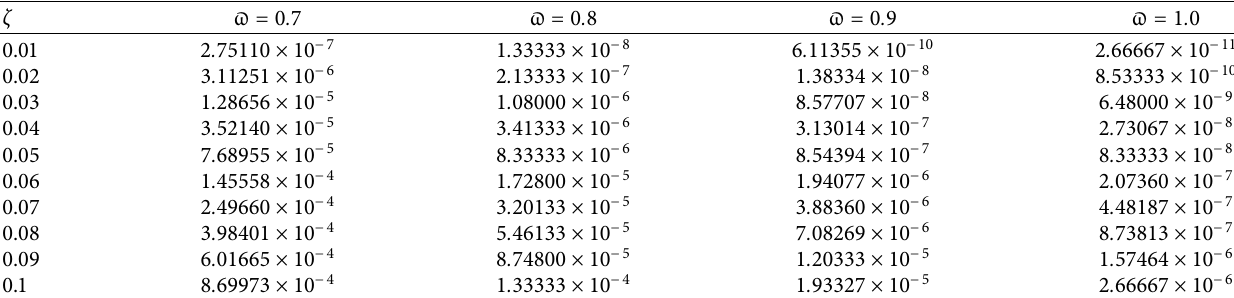
Table 6: | w 5 ( ϰ , ζ ) − w 4 ( ϰ , ζ )| of Problem 3 at diferent values of ϖ at ϰ � 0 . 002 when λ � 2 . 0 determined by LRPSM at plausible locations in the range ζ ∈ [ 0 , 0 . 1 ]